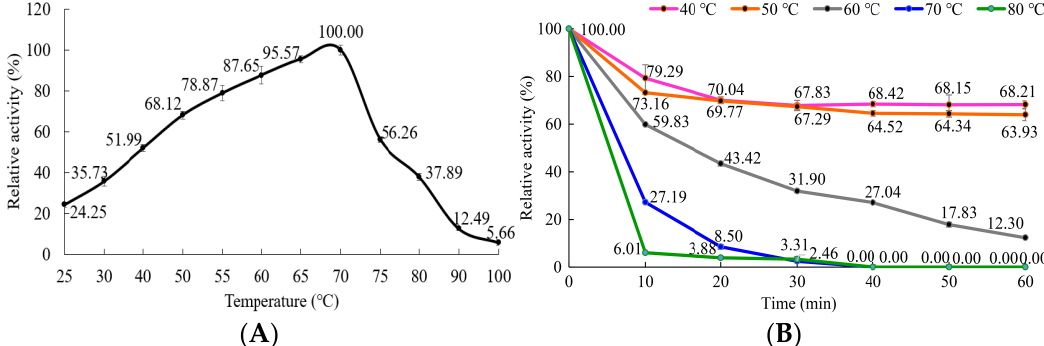
Figure 11. Effect of temperature on α -amylase activity and stability. ( A ) Effect of temperature on α -amylase activity. The optimum temperature of purified BvAmylase activity was determined by measuring the α -amylase activity at different temperatures (25, 30, 40, 50, 55, 60, 65, 70, 75, 80, 90, 100 ◦ C) with the DNS method. ( B ) Effect of temperature on α -amylase stability. The purified BvAmylase was preincubated at different temperatures (40, 50, 60, 70, 80 ◦ C) for 0–60 min, and then the activity was tested by the DNS method at optimum temperature. The highest activity and the activity without preincubating treatment were taken as control (100%). All assays were repeated four times. All of the experimental groups were statistically different from the control experiment ( p < 0.01).